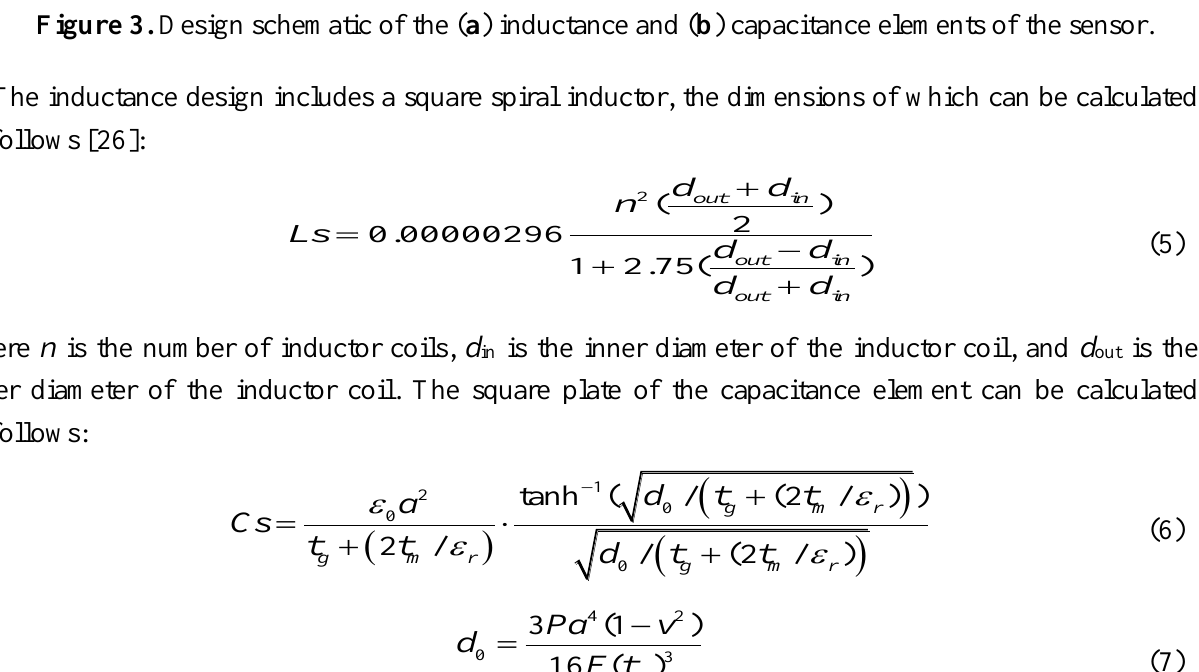
Figure 3. Design schematic of the ( a ) inductance and ( b ) capacitance elements of the